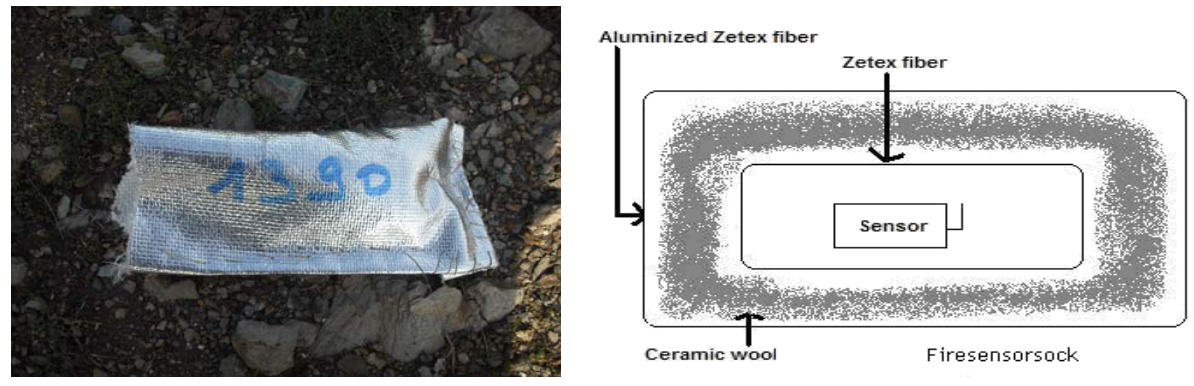
Figure 2. Firesensorsock.